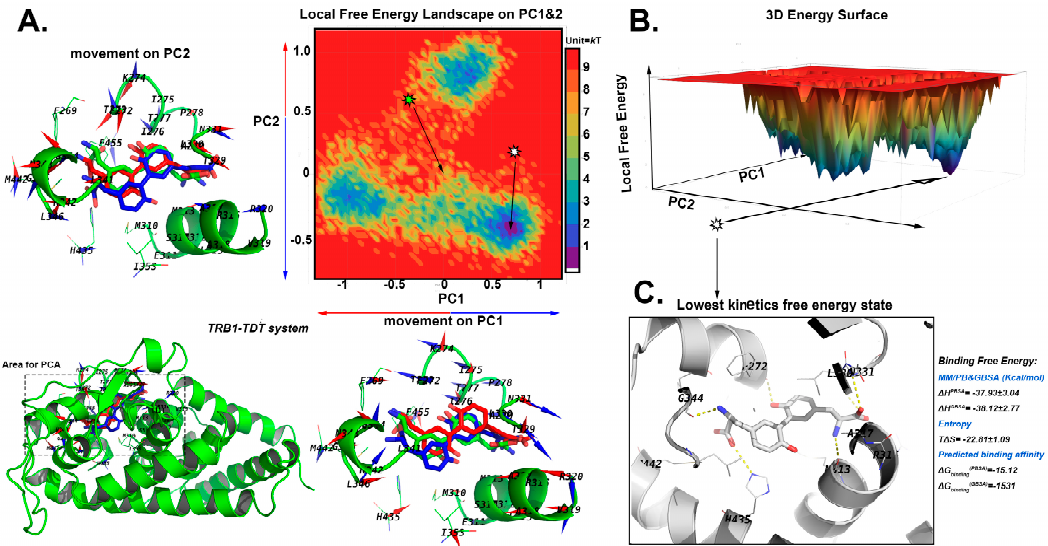
Figure 5. The search for the lowest free energy poses in TR β 1-TDT MD system by local free energy landscape (LFEL) and Molecular Mechanics MM/GB and PBSA calculations. ( A ) The 2D LFEL heat map. Green star shows the docked conformation with the coordinate (0, 0), and is viewed as a reference structure. The highest local free energy was defined as 10 kT, which can barely be sampled from all the conformational space. The bottom left shows the areas for which Principal Component Analysis (PCA) calculations were carried out. The docked pose is in green. The movements on the PC1 and 2 vectors from the production phase simulations are shown as porcupine plots alongside with the axis. The scales of arrows are proportional to the scale of movements observed along each PC. The movements towards positive direction of PC are in blue, and that of negative direction are in red. TDT are in sticks; blue and red sticks represent the minimum and maximum conformations observed by the PC vectors and surrounding residues are shown as cartoon. The docked pose is coloured in green. ( B ) The converted 3D surface of FEL with the same colour code as shown in panel A. ( C ) The collected state with lowest kinetic free energy. The protein is in white cartoon, TDT are shown by sticks, and the nearby residues are shown as white lines. The hydrogen bonds are indicated by yellow dashes. The collected conformation and the nearby 50 frames were used for calculating the binding free energy, which are displayed next to panel C.